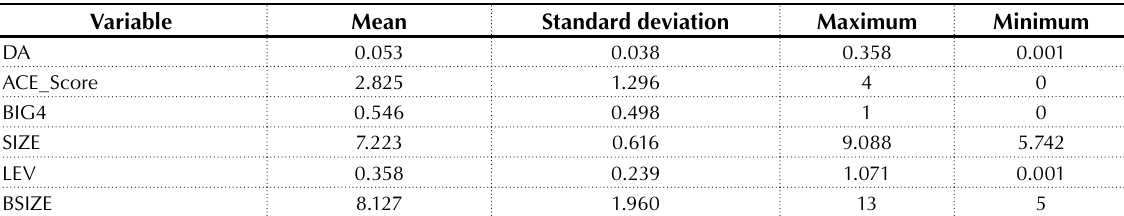
Table 1. Descriptive